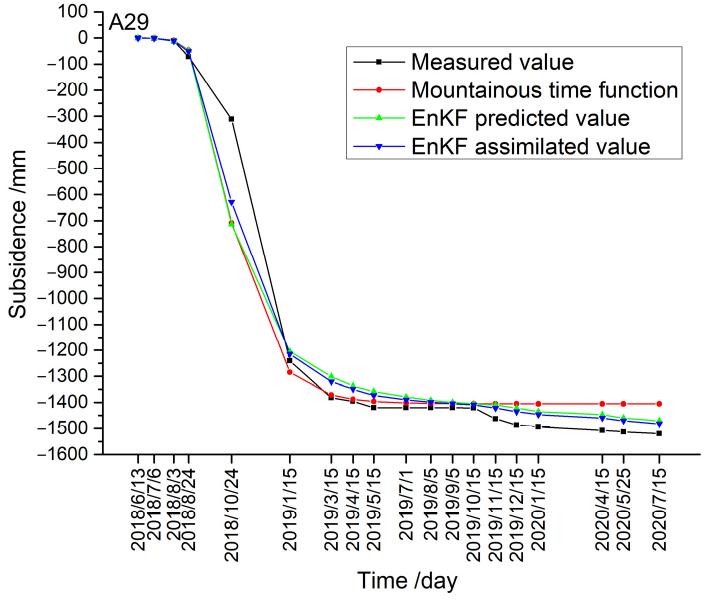
Figure 8. Subsidence curves of A29 using different methods.